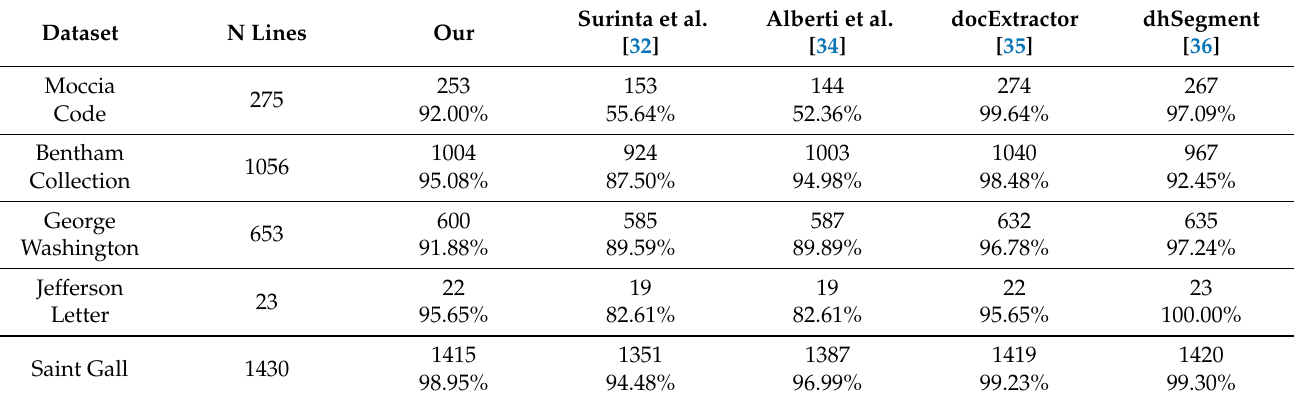
Table 1. Line segmentation results. The table reports, for each data set, the actual number and the number of correctly segmented text lines provided by each